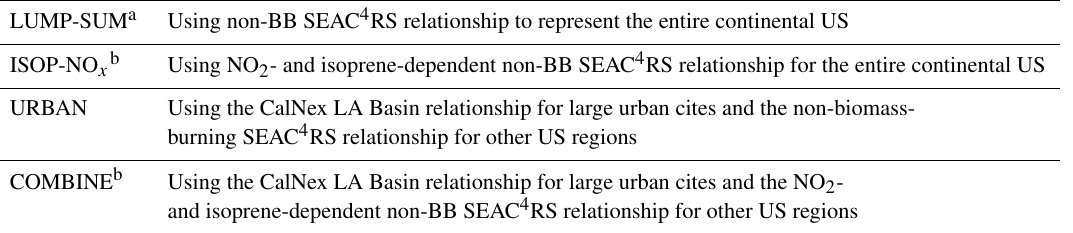
Table 2. Cases to estimate OA surface concentrations, based on the choice of slope and intercept from a linear regression relationship between OA and HCHO data found in Table